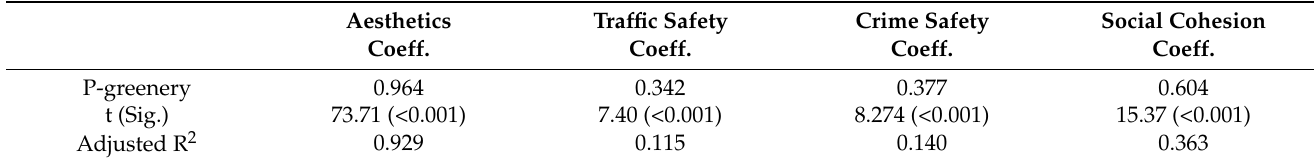
Table 2. The association between green space and mediators.